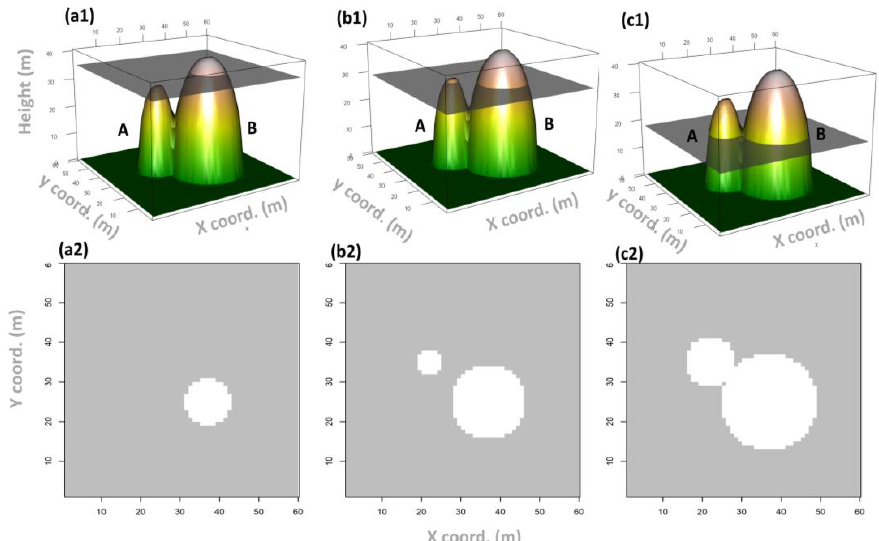
Figure 4. Graphical illustration of separating different sized tree crowns using the disk structuring elements (SE)-based process on a CHM, containing tree A (smaller) and tree B (larger). The illustrations ( a1 – c1 ) represent the scanning window process on CHM, and ( a2 – c2 ) are the corresponding cross-sections produced from ( a1 ) to ( c1 ), respectively.